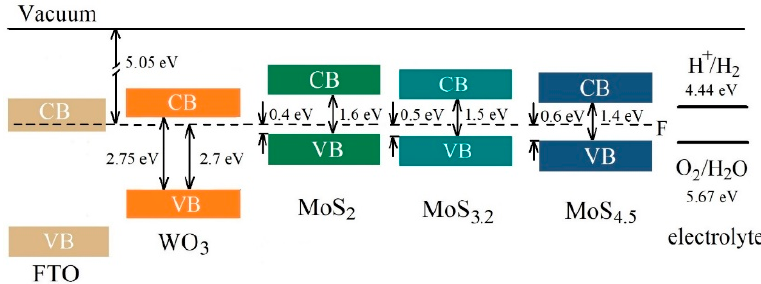
Figure 15. The proposed energy band diagrams for MoS 2 /WO 3 /FTO, MoS 3.2 /WO 3 /FTO, and MoS 4.5 /WO 3 /FTO samples. The schema represents the band offsets between WO 3 with thin MoS x films. CB and VB indicate the conduction band and valence band, respectively.